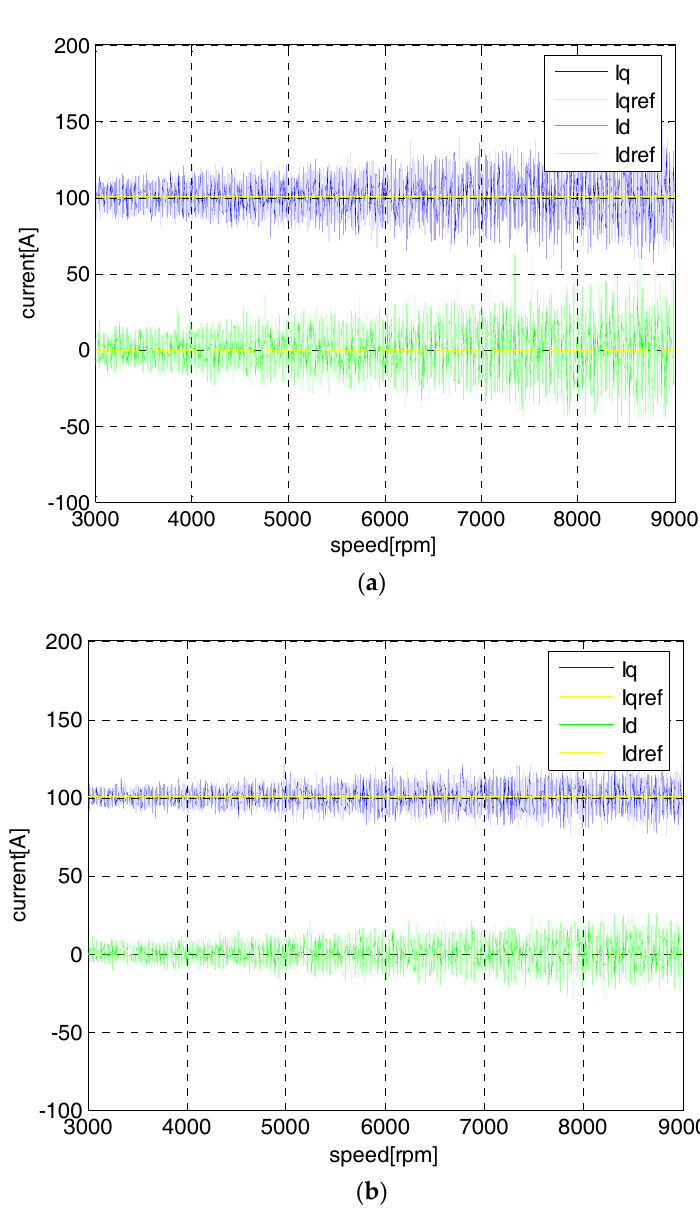
Figure 10. The close-loop control performance at 9000 rpm by using one-step observer ( a ) and two-step observer ( b ).